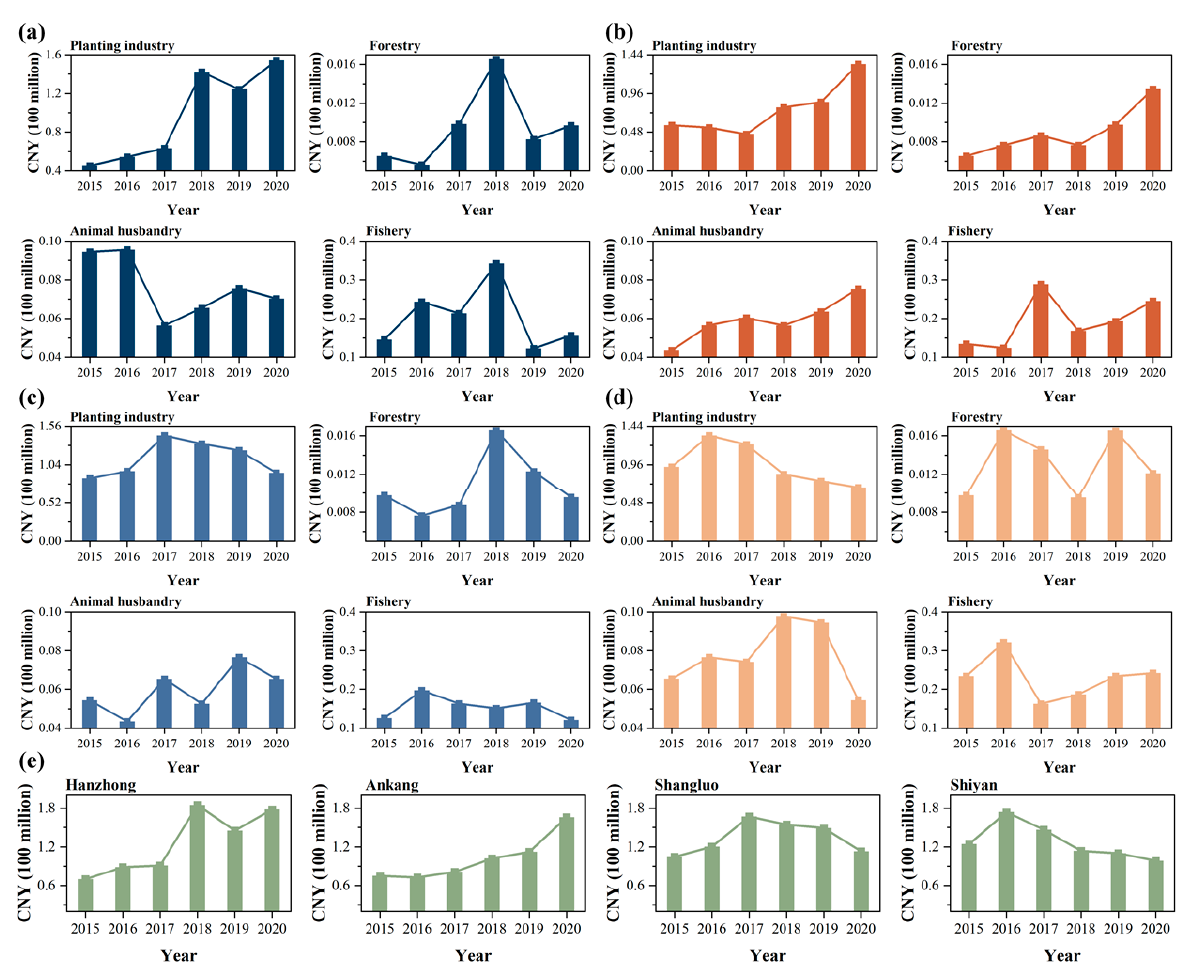
Figure 4. The opportunity cost of primary industry in ( a ) Hanzhong, ( b ) Ankang, ( c ) Shangluo, and ( d ) Shiyan among the main headwater areas from 2015 to 2020, ( e ) total opportunity cost changes of primary industry.